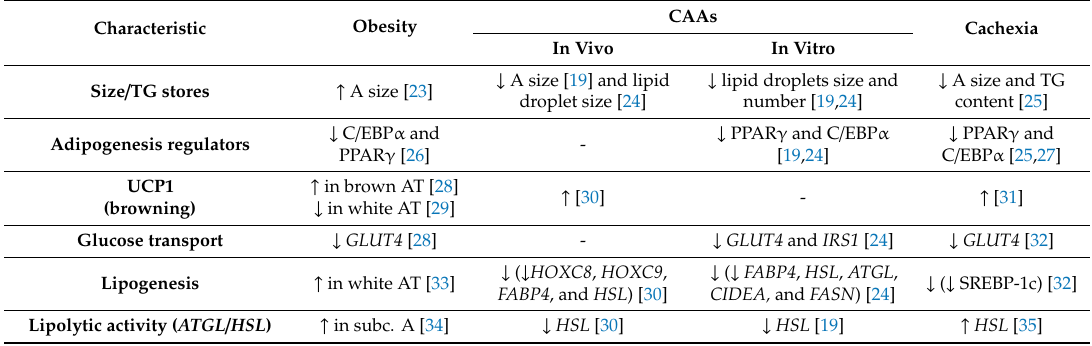
Table 1. Comparison of adipocyte features in obesity, cachexia and after interaction with tumor